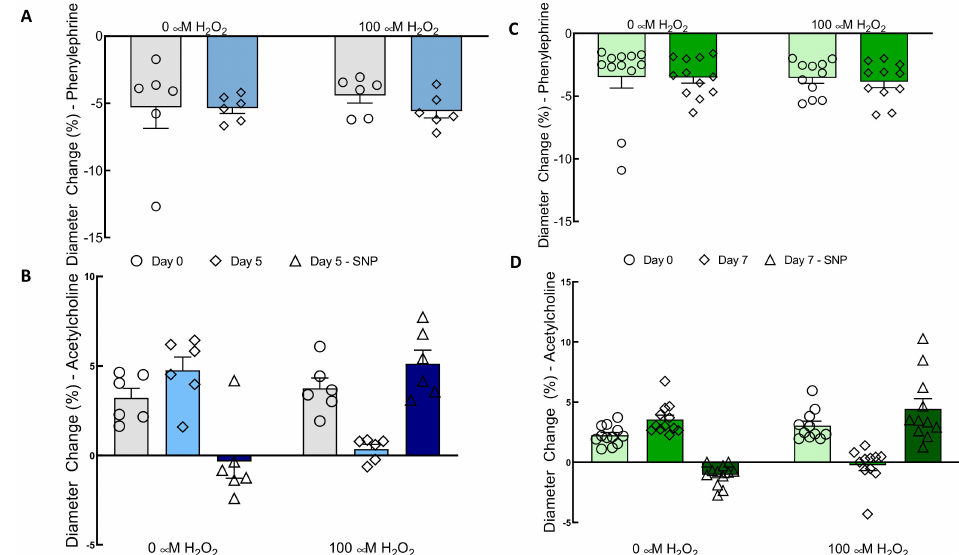
Figure 4. Treatment with 100 µ M H 2 O 2 for five or seven days eliminated